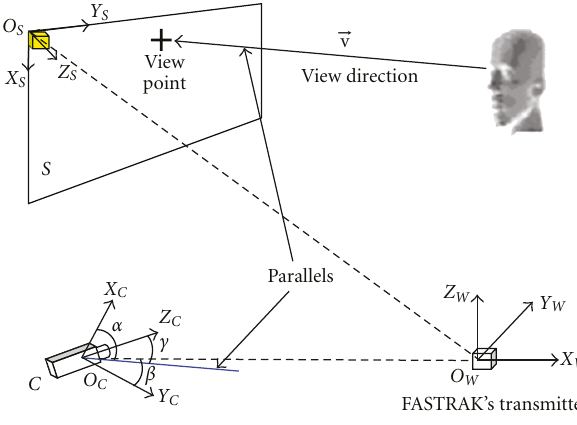
Figure 7: Studio